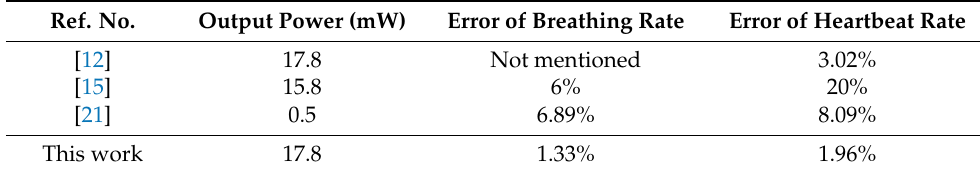
Table 6. Comparison of the proposed algorithm with other works. Ref. No.